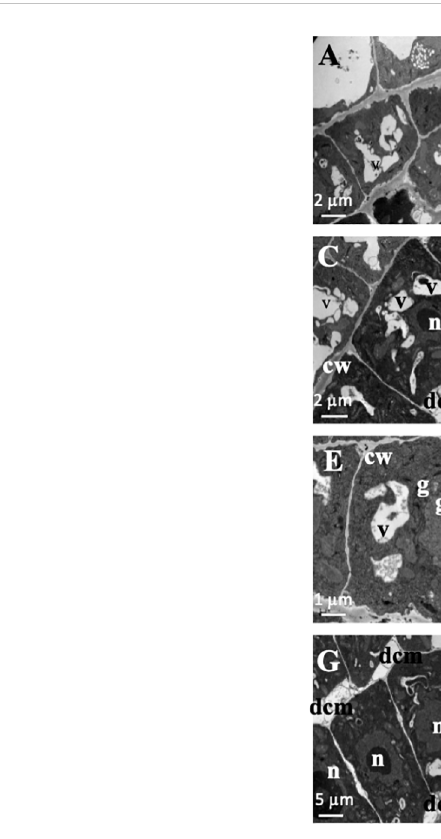
FIGURE 4 Images of transmission electron microscopy (TEM) of Arabidopsis thaliana roots treated with IC 50 of TC for 14 days. (A – C, G, H) Cells with detached cell membranes and cytoplasm vacuolated. (D – F) Vacuolated cells with active Golgi apparatus. (n, nucleus; cw, cell wall; dcm, detached cell membrane; v, vacuole; g, Golgi apparatus). Scale bars: (A, C, H) : 2 µm; (B, G) : 5 µm; (D – F) : 1